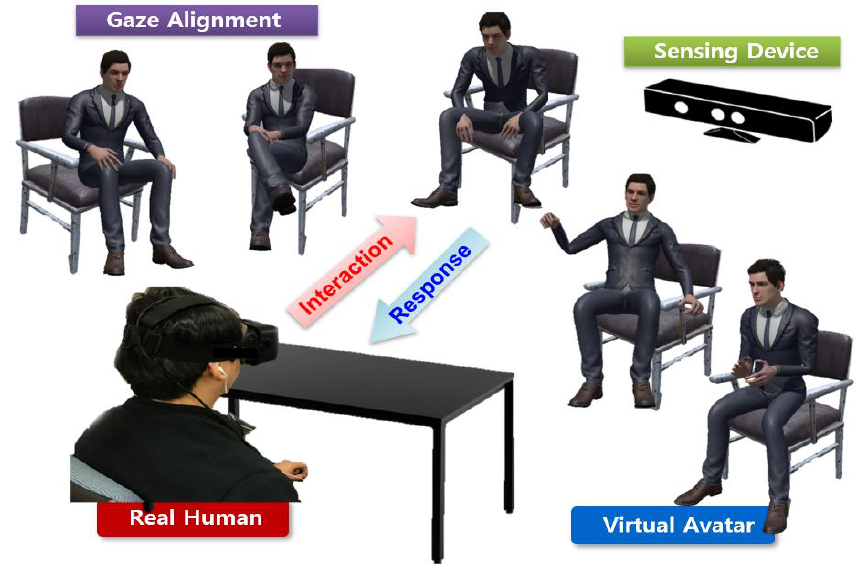
Figure 3. The system configuration of our adaptive control for gaze alignment of the teleported avatar. A participant is wearing an MR see-through headset, and a sensing device is used for detecting the gaze direction of the participant. At this time, the virtual teleported avatar is made to match the gaze of the participant depending on the avatar’s position, associated with available real objects on which the avatar can sit during the conversation.